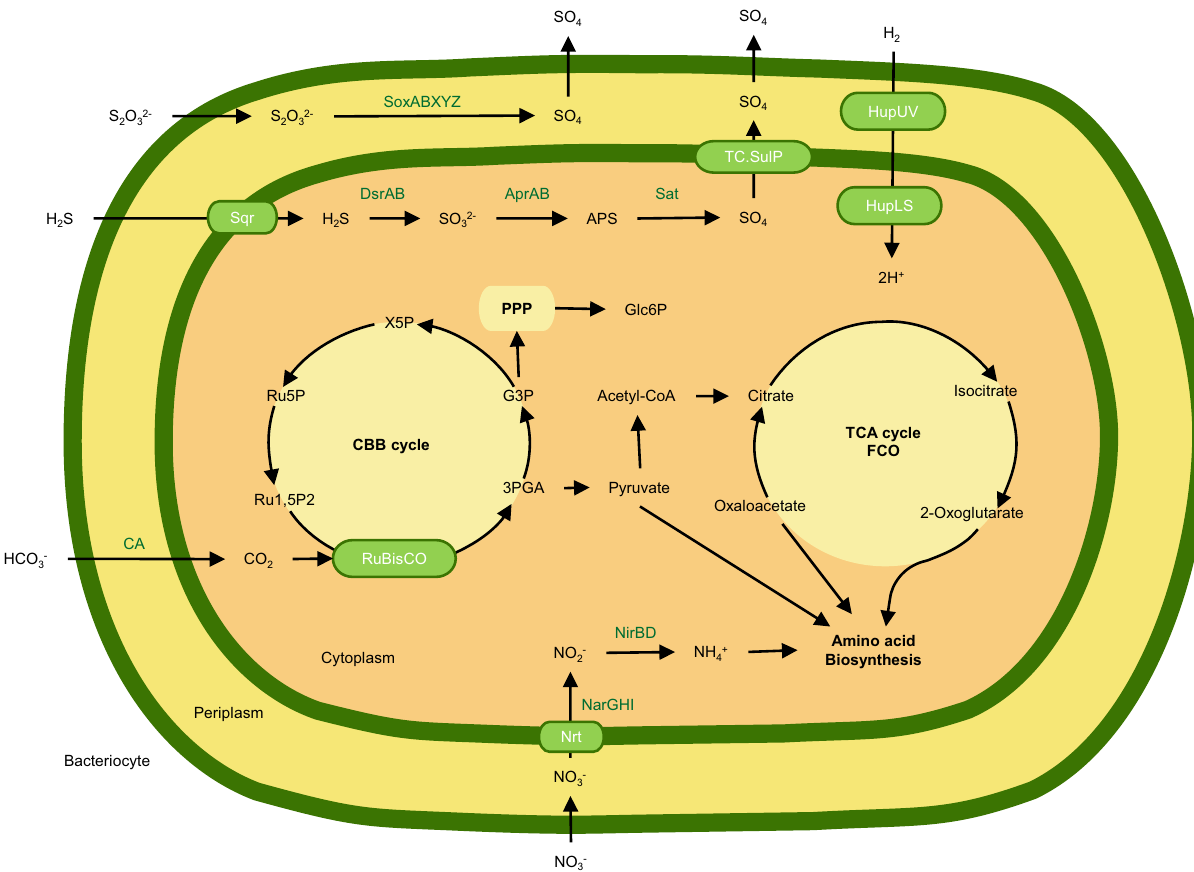
Figure 3. Schematic diagram of key metabolism found in B. thermophilus EPR9N symbiont genome. FCO First carbon oxidation, Glc6P α-D-Glucose-6-phosphate, PPP Pentose Phosphate Pathway, G3P Glyceraldehyde-3- phosphate, 3PGA 3-Phospho-glyceric acid, Ru1, 5P2 Ribulose 1,5-bisphosphate, Ru5P Ribulose 5-phosphate, X5P Xylulose 5-phosphate, Nar Nitrate reductase, Nir nitrite reductase, Hup Ni/Fe hydrogenase. Subcellular localization of bacterial proteins for constructing schematic metabolic pathway were predicted by PSORTb 3.0 webtool 93